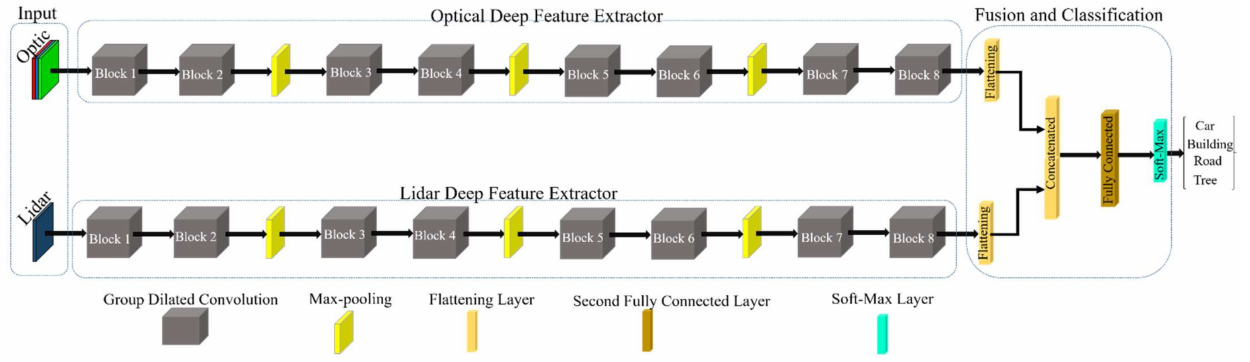
Figure 3. Proposed CNN model